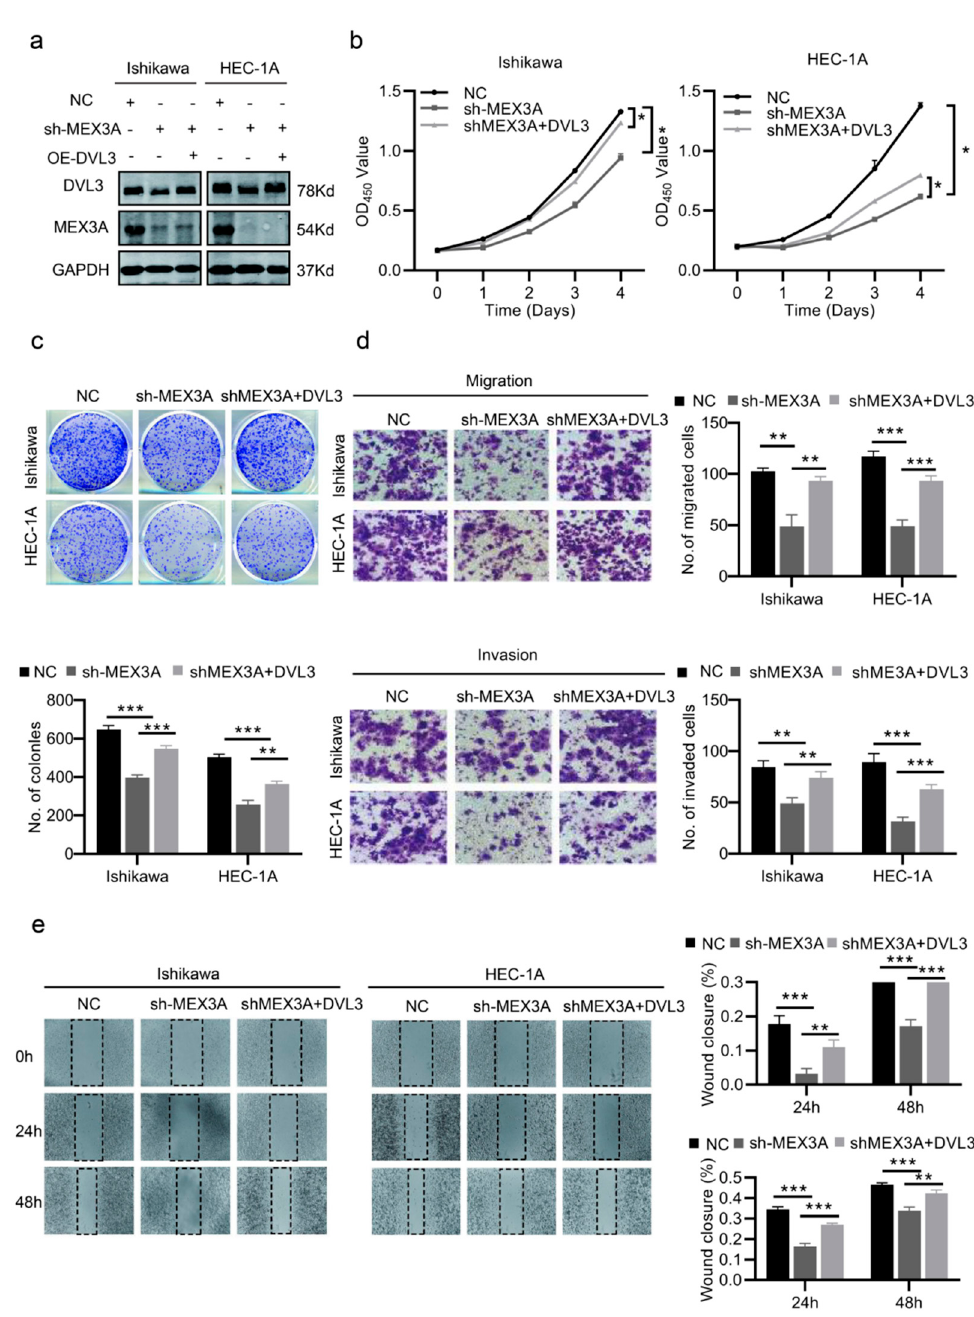
Figure 7. DVL3 is vital for the function of MEX3A in EC cell proliferation and migration. ( a ) The protein levels of MEX3A and DVL3 in Ishikawa and HEC-1A cells treated after MEX3A knockdown or DVL3 overexpression. ( b , c ) CCK-8 and colony-formation assays (200 × ) in different treatment groups (NC, sh-MEX3A, sh-MEX3A+ OE-DVL3). ( d , e ) Transwell and wound-healing assays performed with the indicated Ishikawa and HEC-1A cells (200 × ). * p < 0.05, ** p < 0.01, *** p < 0.001.